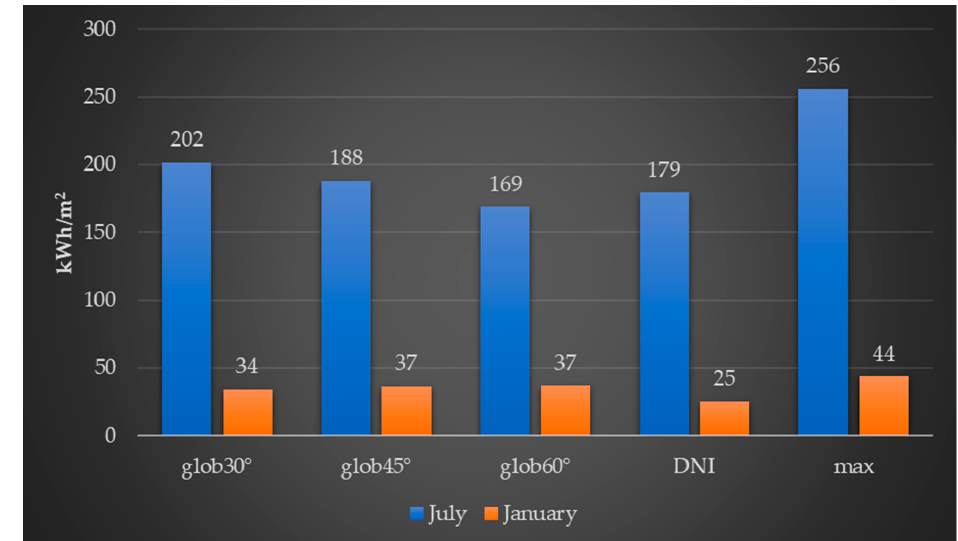
Figure 11. The yearly sum of Direct Normal Irradiance (DNI), direct beam, and diffuse irradiance incident on an inclined plane that is tracking the sun (max), radiation incident on a plane with 30 degree inclination (glob30°), with 45 degree inclination (glob45°), and with 60 degree inclination (glob60°).